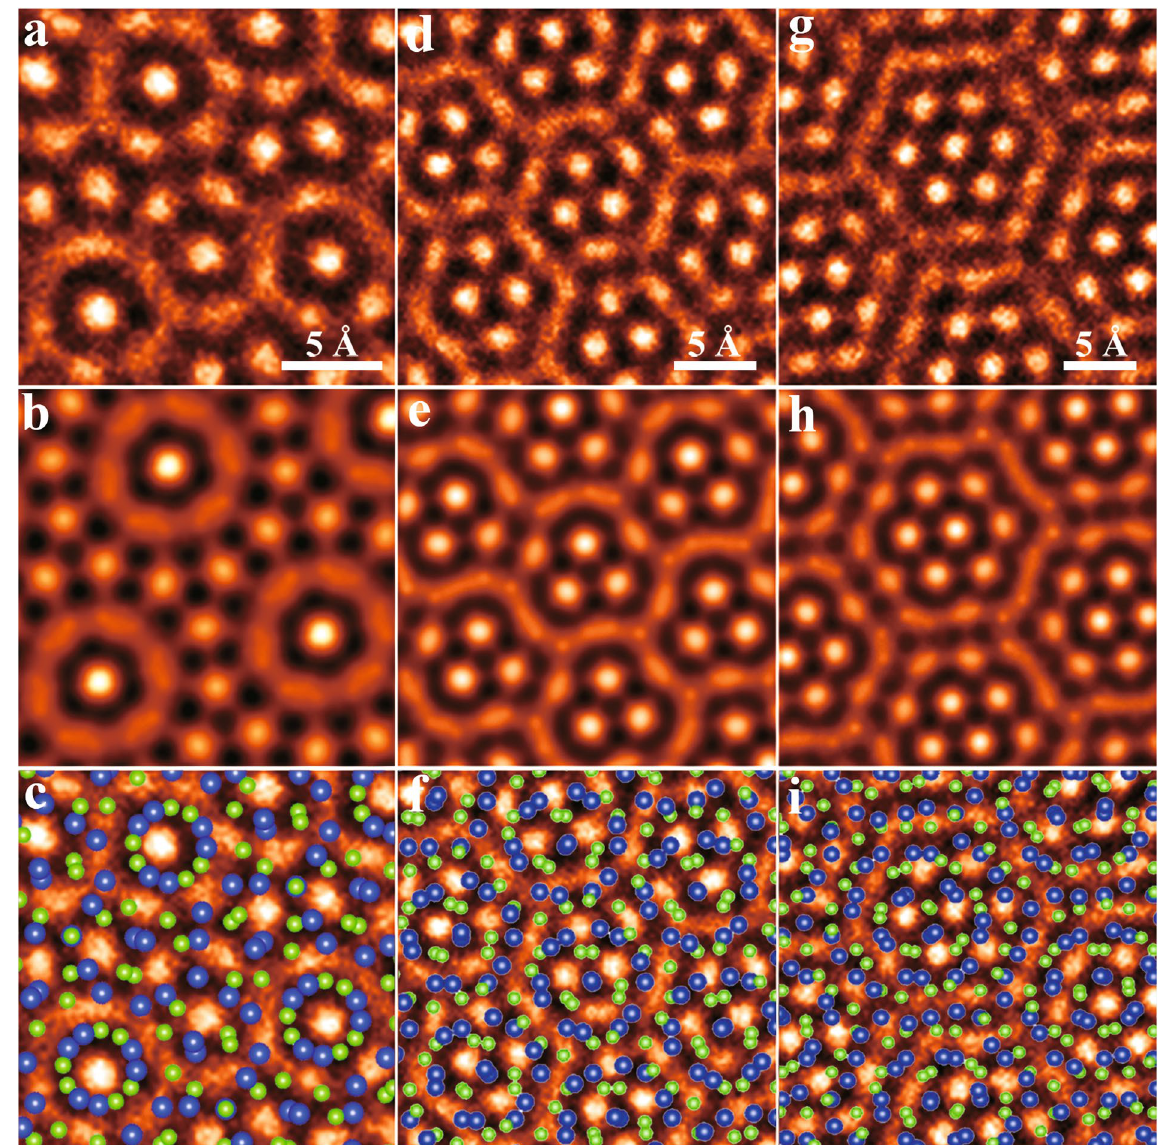
Figure 3. Experimental and simulated HRTEM images of Zones A-C in Fig. 2a. ( a ) Experimental and ( b ) simulated image of Zone A, where false color is used to aid visual inspection. ( c ) Overlay of ( a ) with the atomic model of ( b ), where the blue and the green dots denote the Mo and S atoms, respectively. ( d–f ) and ( g–i ) have the same meanings as ( a–c ) and correspond to Zones B and C,